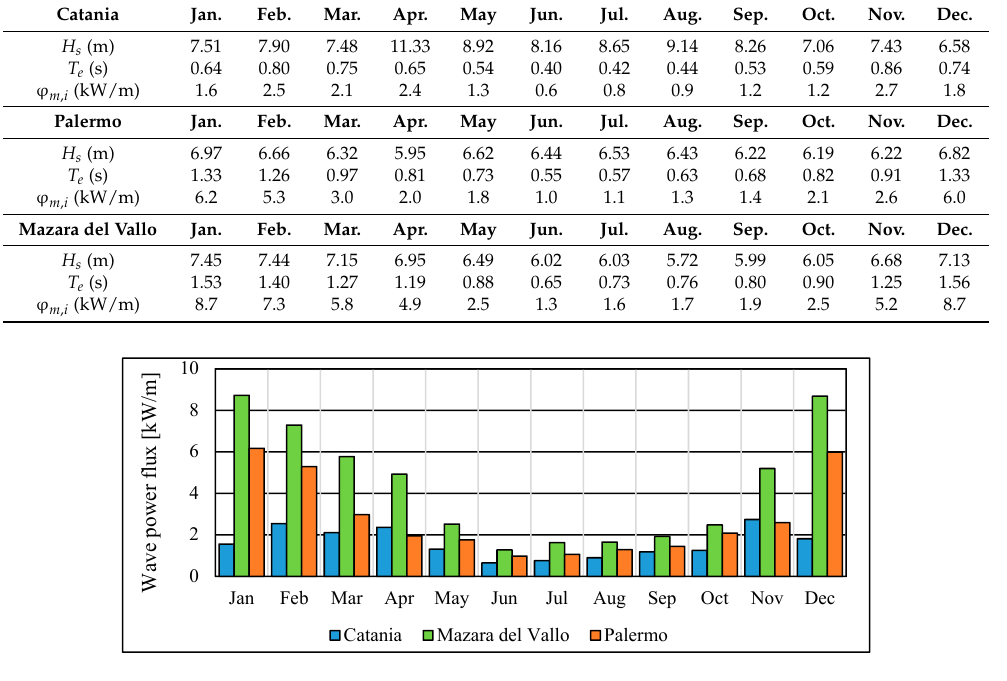
Figure 8. Monthly average wave power flux in Catania, Palermo, and Mazara del Vallo (2002–2011).